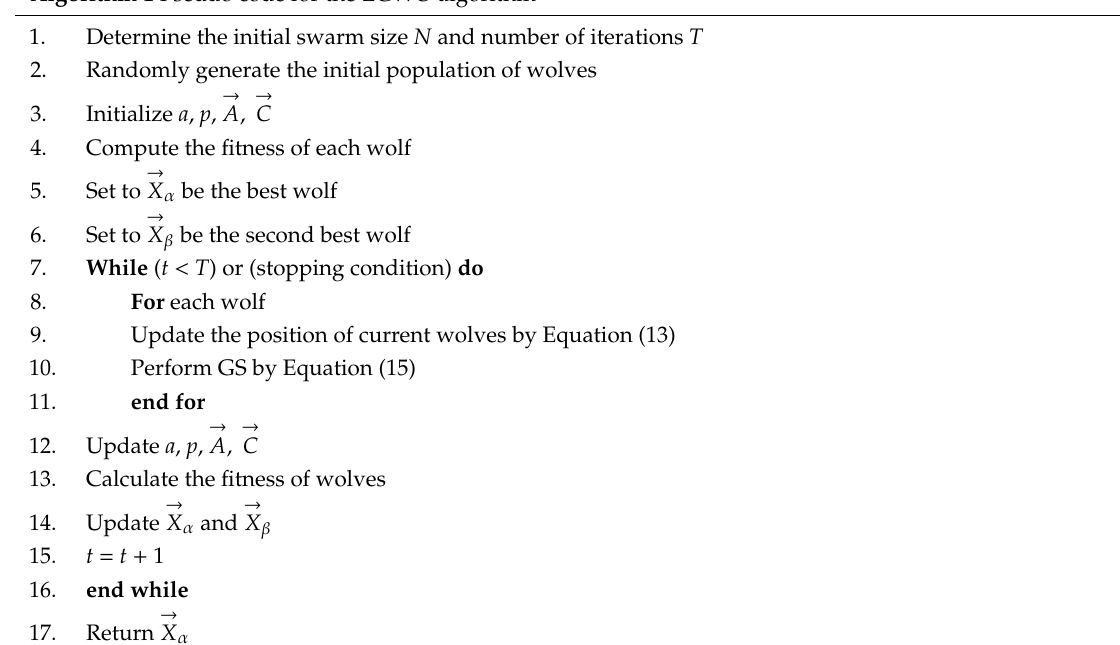
Algorithm 1 Pseudo code for the LGWO